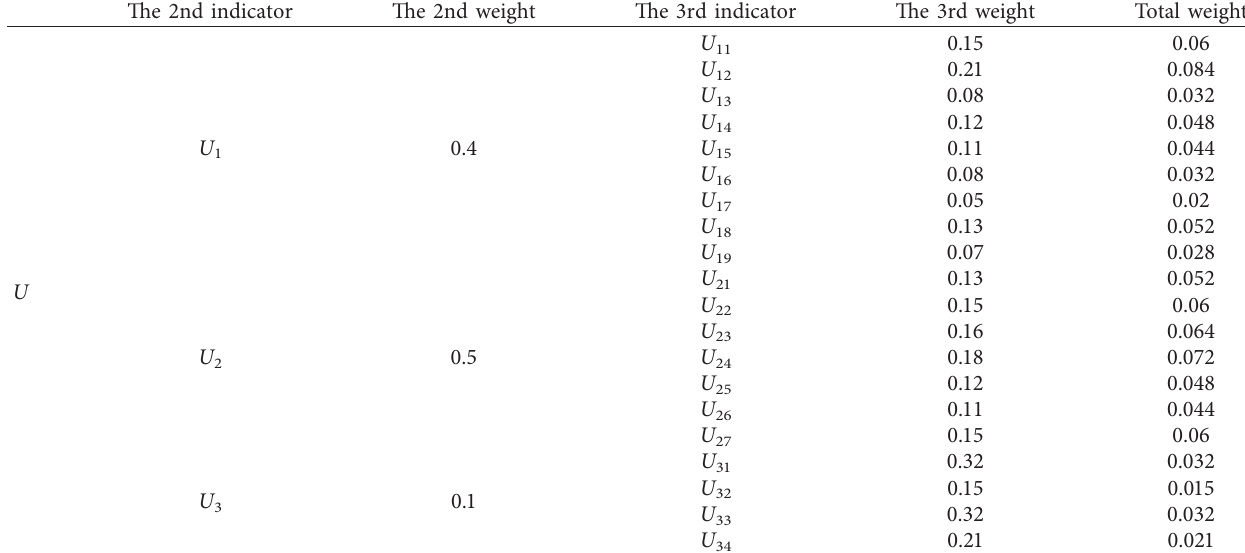
Table 5: Risk factor of G1 method.